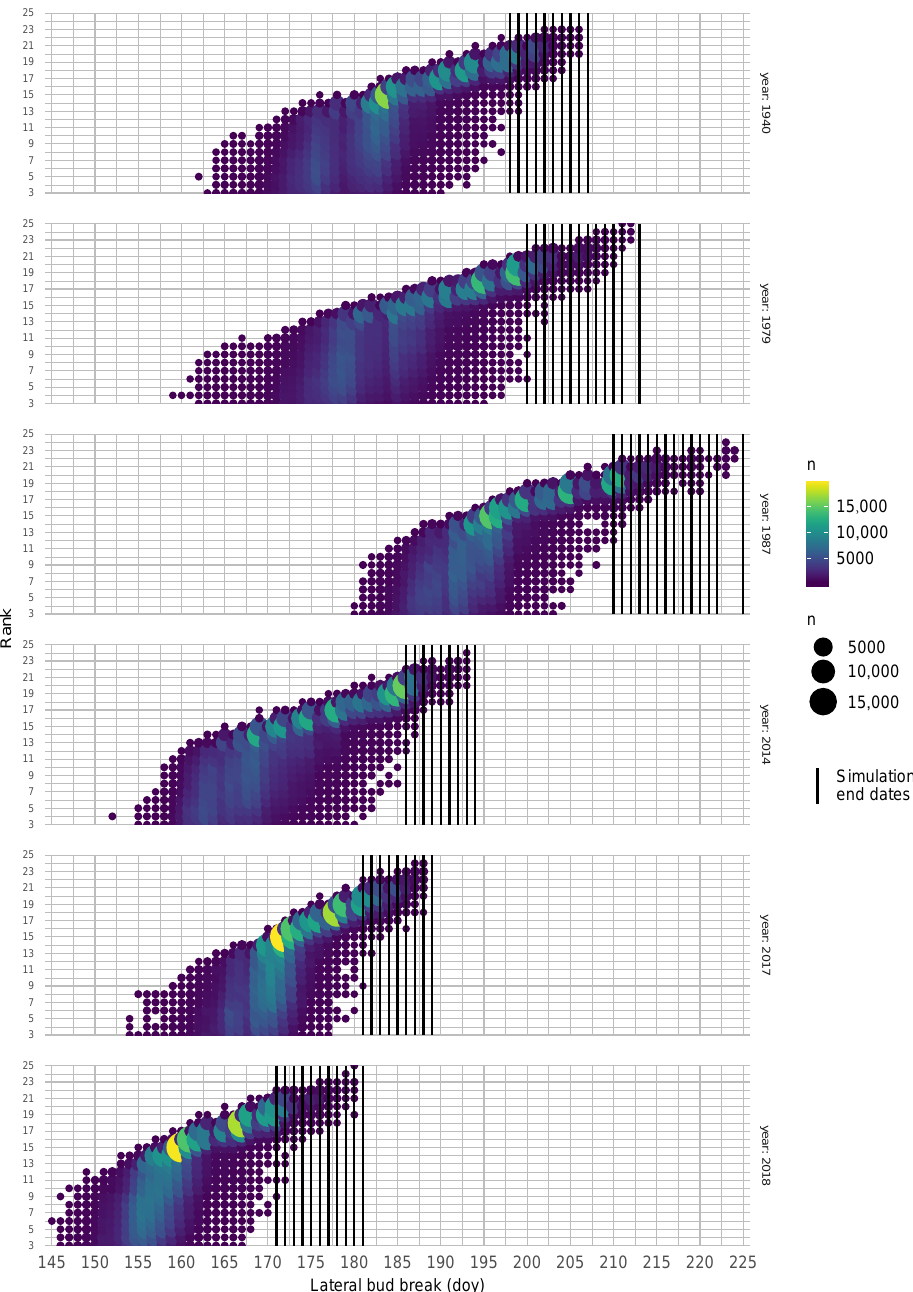
Figure 13. Lateral bud break counts of different ranks at day of year (DOY) for all simulations ( n = 2000 per